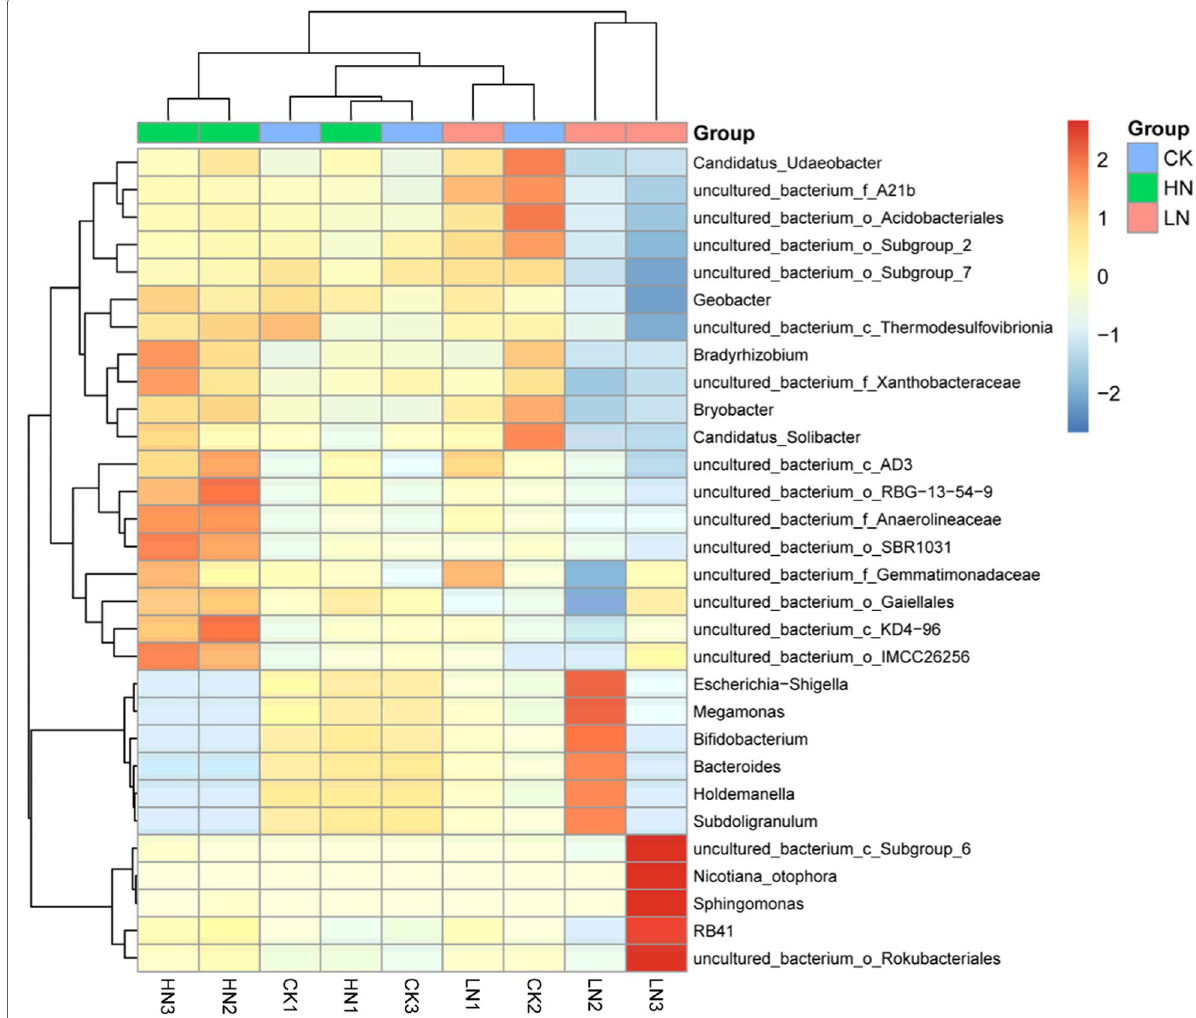
Fig. 5 Heatmap and hierarchical clustering of the relative abundances of the top‑30 genera detected in the soil bacteiral communities